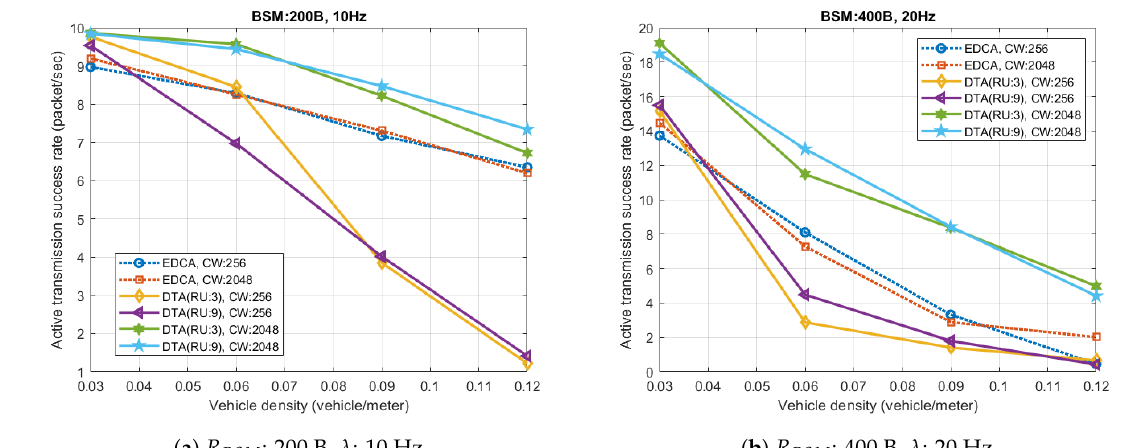
Figure 7. Active BSM transmission success